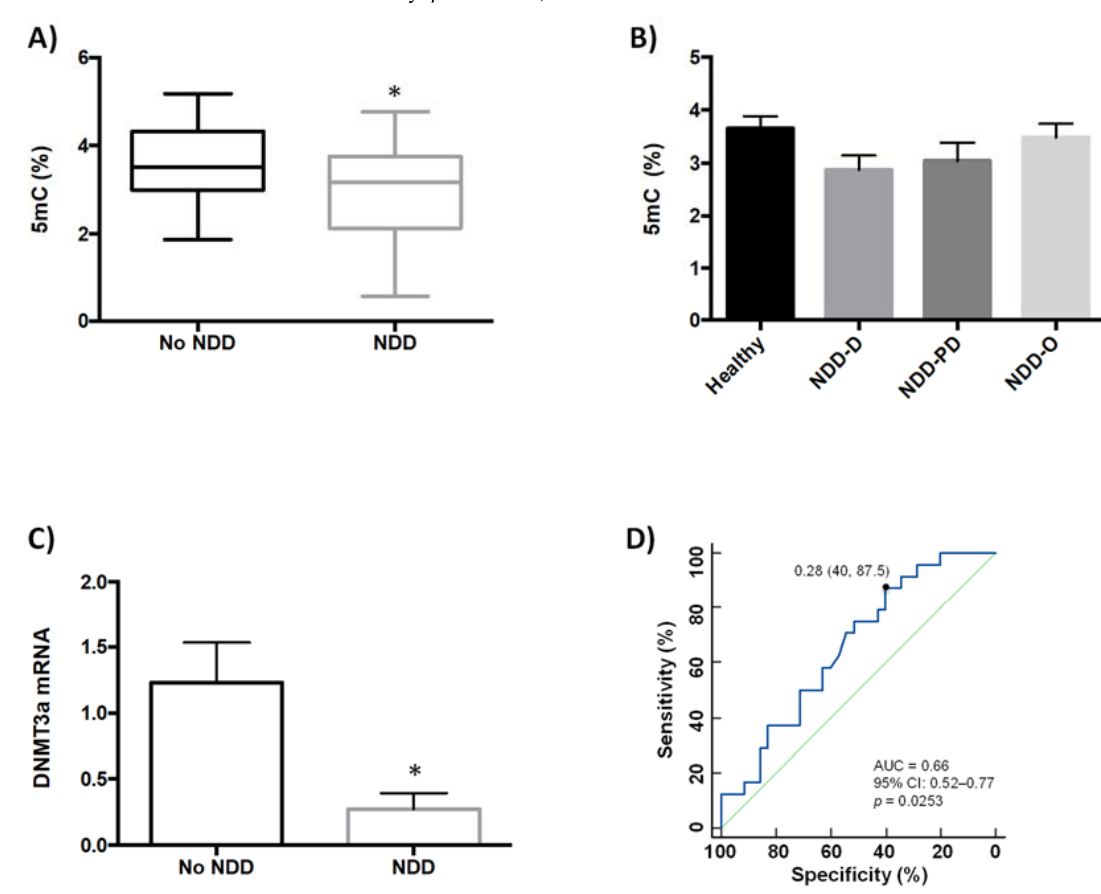
Figure 1. Analysis of global DNA methylation in blood samples from healthy subjects and patients with NDDs. ( A ) Global DNA methylation (5mC, %) levels were measured colorimetrically using buffy coat samples from healthy individuals ( n = 2), and patients with NDDs ( n = 35); unpaired t test (* p < 0.05). ( B ) 5mC levels (%) in healthy individuals ( n = 25) and patients with NDD subtypes; NDD-D ( n = 21), NDD-PD ( n = 7), and NDD-O ( n = 7); one-way ANOVA with post hoc Bonferroni correction for multiple comparisons ( p = 0.256). ( C ) qPCR was performed in samples from the no-NDD and NDD-D groups with TaqMan probes for DNMT3a ; unpaired t test (* p < 0.05). Data are presented as the mean ± S.E.M. ( D ) ROC curve to discriminate subjects without NDDs from patients with NDDs; AUC for 5mC was 0.66 (95% CI: 0.52–0.77), p = 0.0253. The optimal cutoff value according to the Youden’s index was 0.28 (specificity: 40%, sensitivity: 87.5%) (black filled circle). The diagonal green line is a reference line that corresponds to the ROC curve of a diagnostic test that has no diagnostic ability. 5mC, 5-methylcytosine; AUC, area under the curve; CI, confidence interval; DNMT3a, DNA methyltransferase 3a; NDD, patients with neurodegenerative diseases; no-NDD, individuals with no NDDs; NDD-D, NDD patients with dementia; NDD-PD, patients with a range of parkinsonisms representing PD and PD-like disorders; NDD-O; patients with other types of NDDs, such as Huntington’s disease, multiple sclerosis; PD, Parkinson’s disease; qPCR, quantitative real-time PCR; ROC, receiver operating